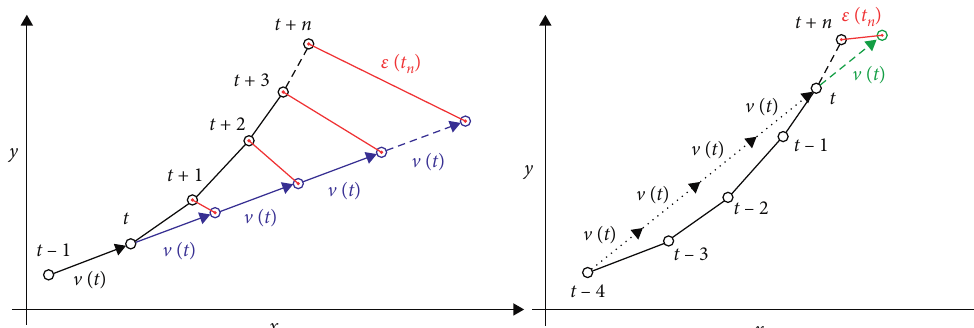
Figure 3: Illustration of the linear extrapolation schemes for the LK group: on the left LK-Lin1 and on the right LK-Lin4. The location error is displayed by ε ( t n ).